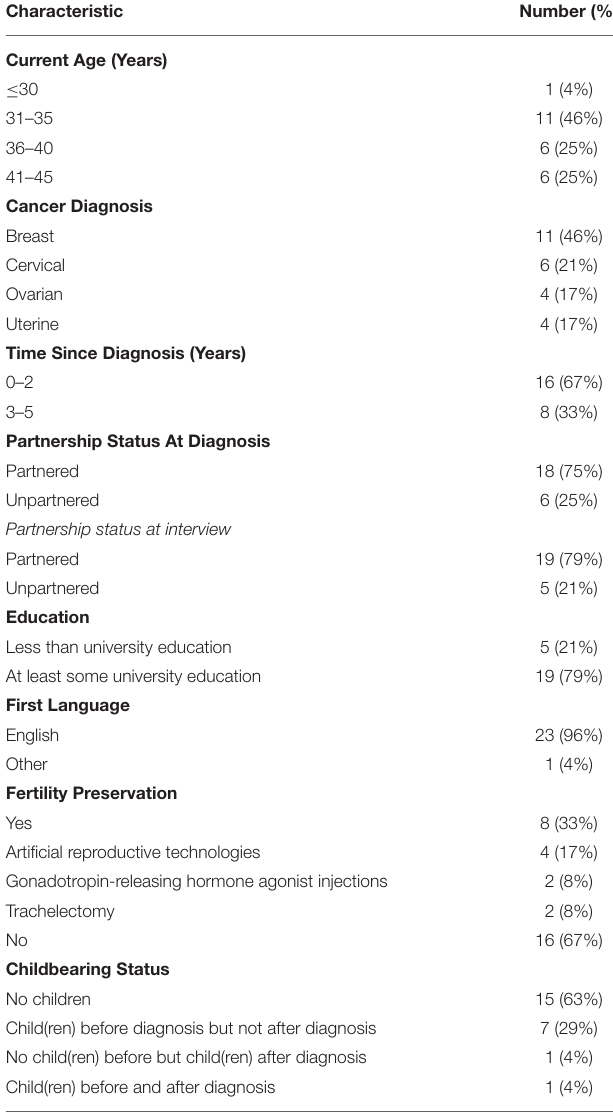
TABLE 1 | Participants’